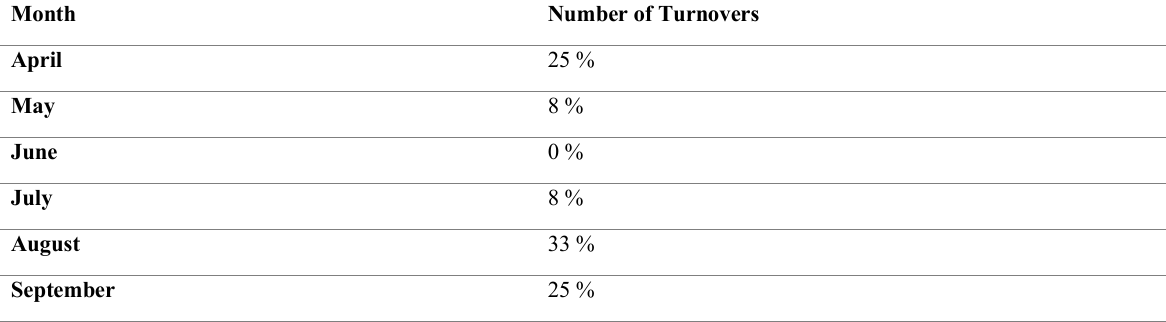
Table 1: Turnover of PT X Employees in